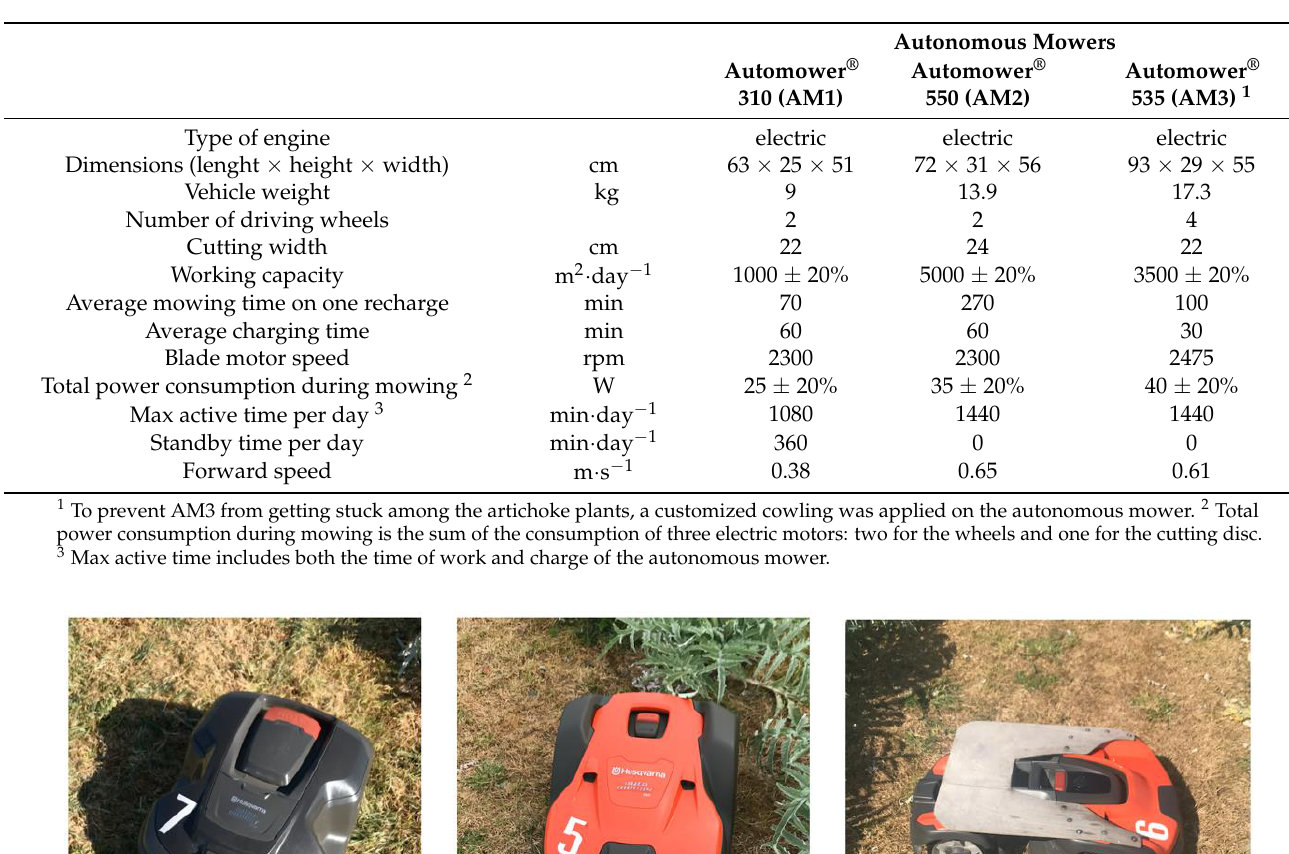
Table 1. Autonomous mowers’ main characteristics.